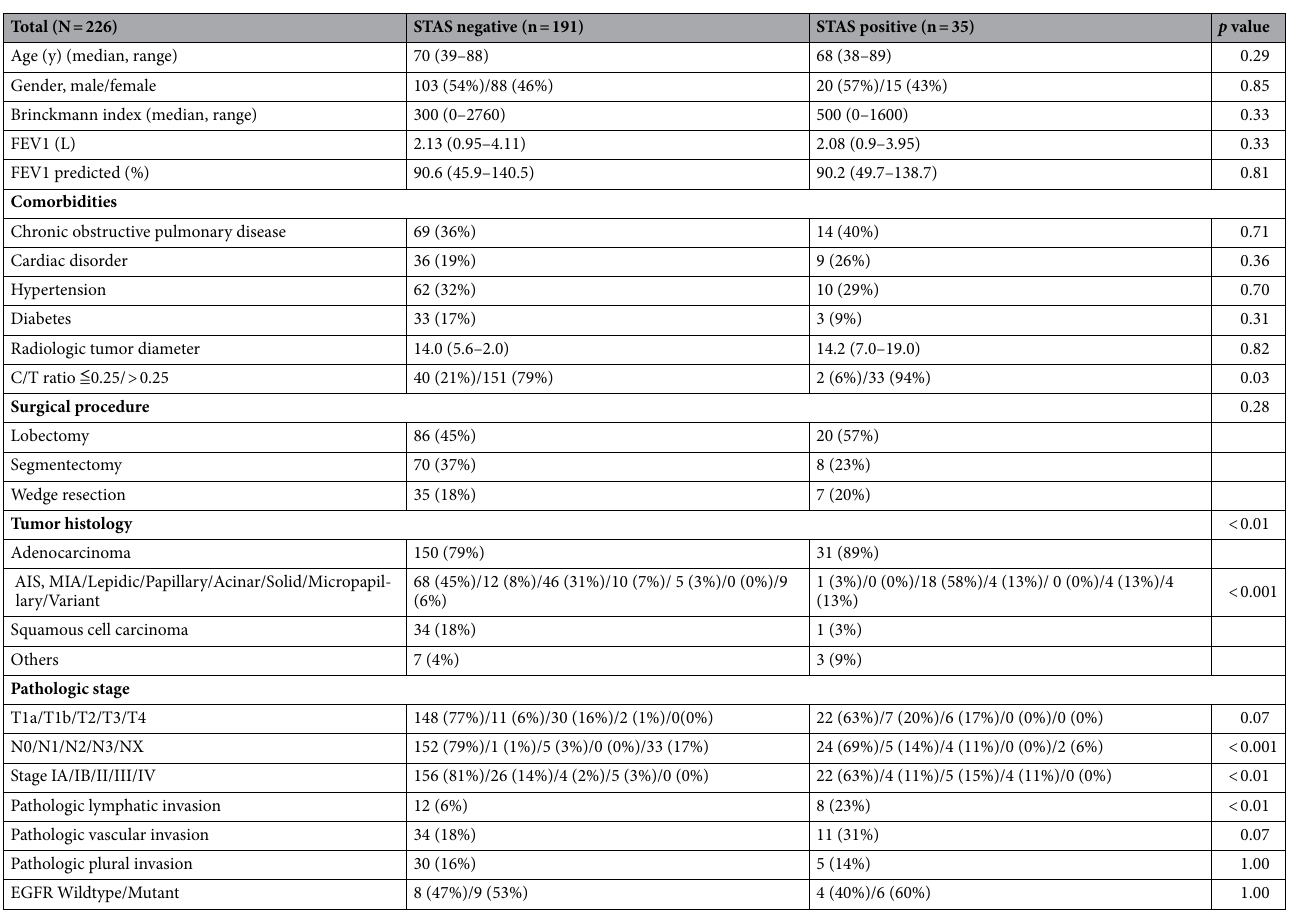
Table 1. Patients’